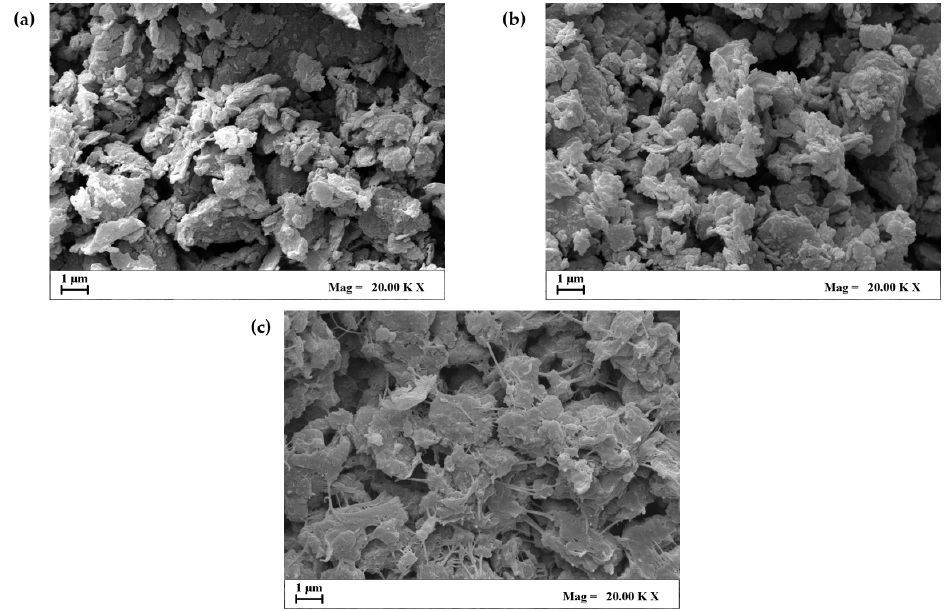
Figure 4. FESEM images of graphite ( a ), of a sample consisting of graphite and of polybutadiene with a terminal pyrene ( b ) and of a sample consisting of polybutadiene (without terminal pyrene) and graphite ( c ).